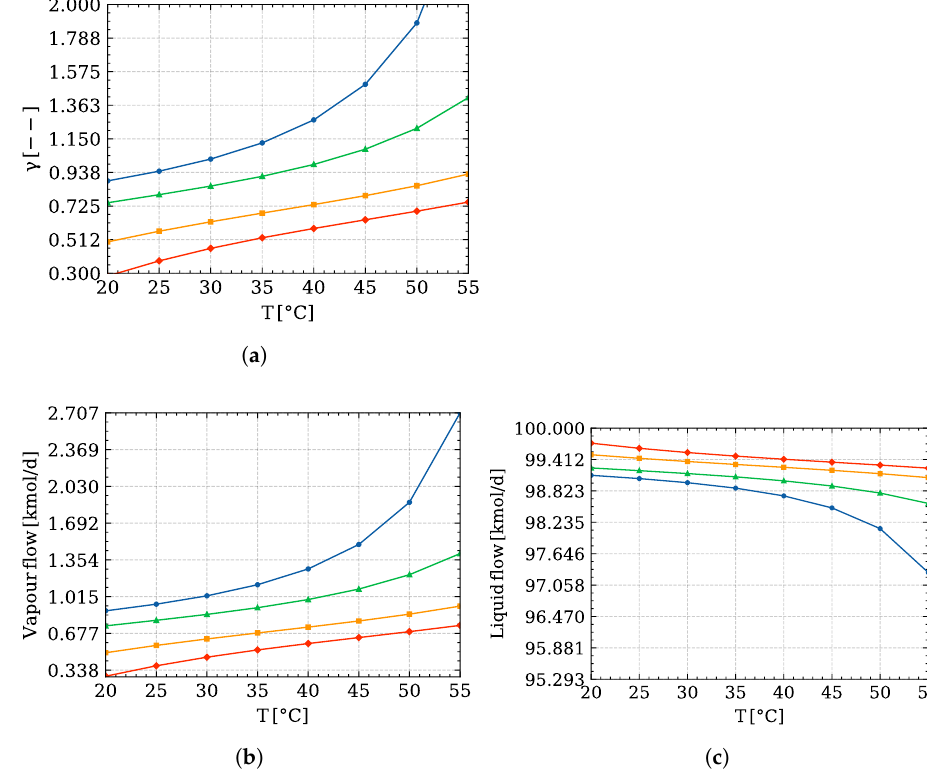
Figure 4. ( a ) Trend of the value of the vapour fraction γ with respect to temperature and pres- sure, evaluated through Equation (10); trends of the vapour ( b ) and liquid ( c ) molar flows with respect to temperature and pressure;